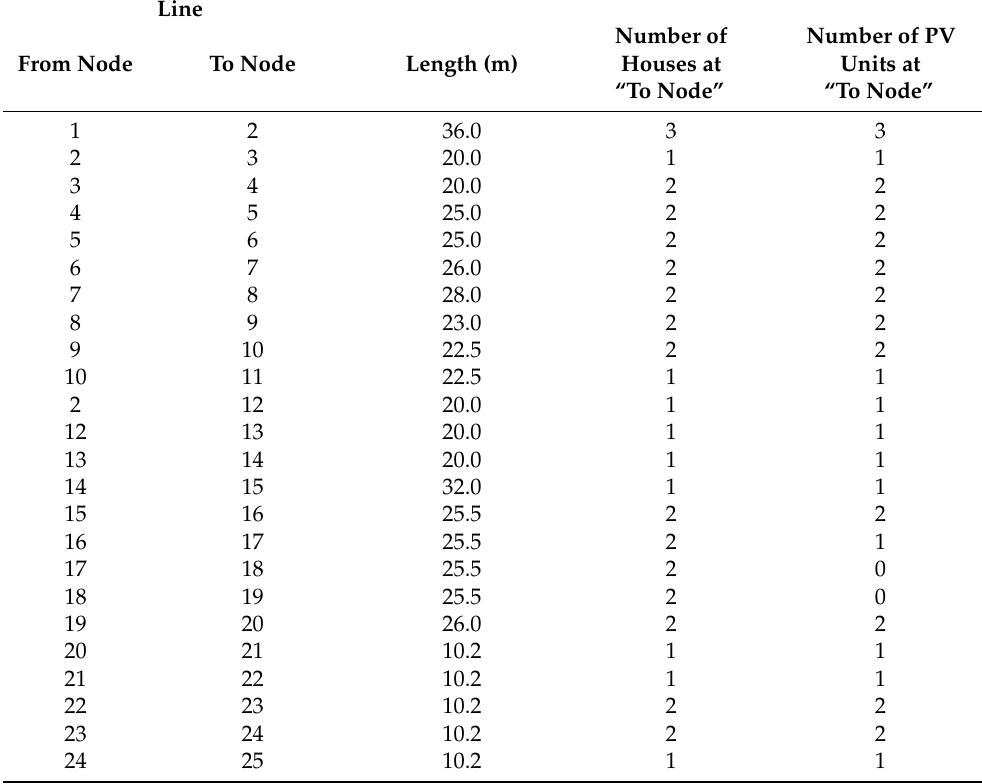
Table 1. The branch lengths, number of households and PV units connected to the nodes.